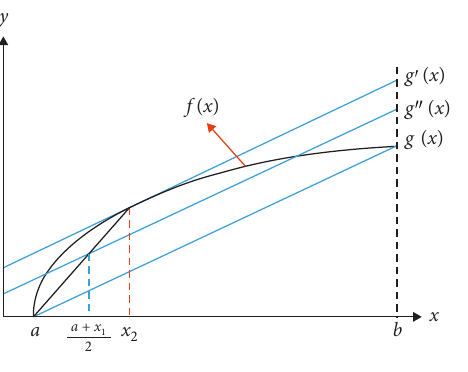
Figure 3: Plane instantaneous equivalence I